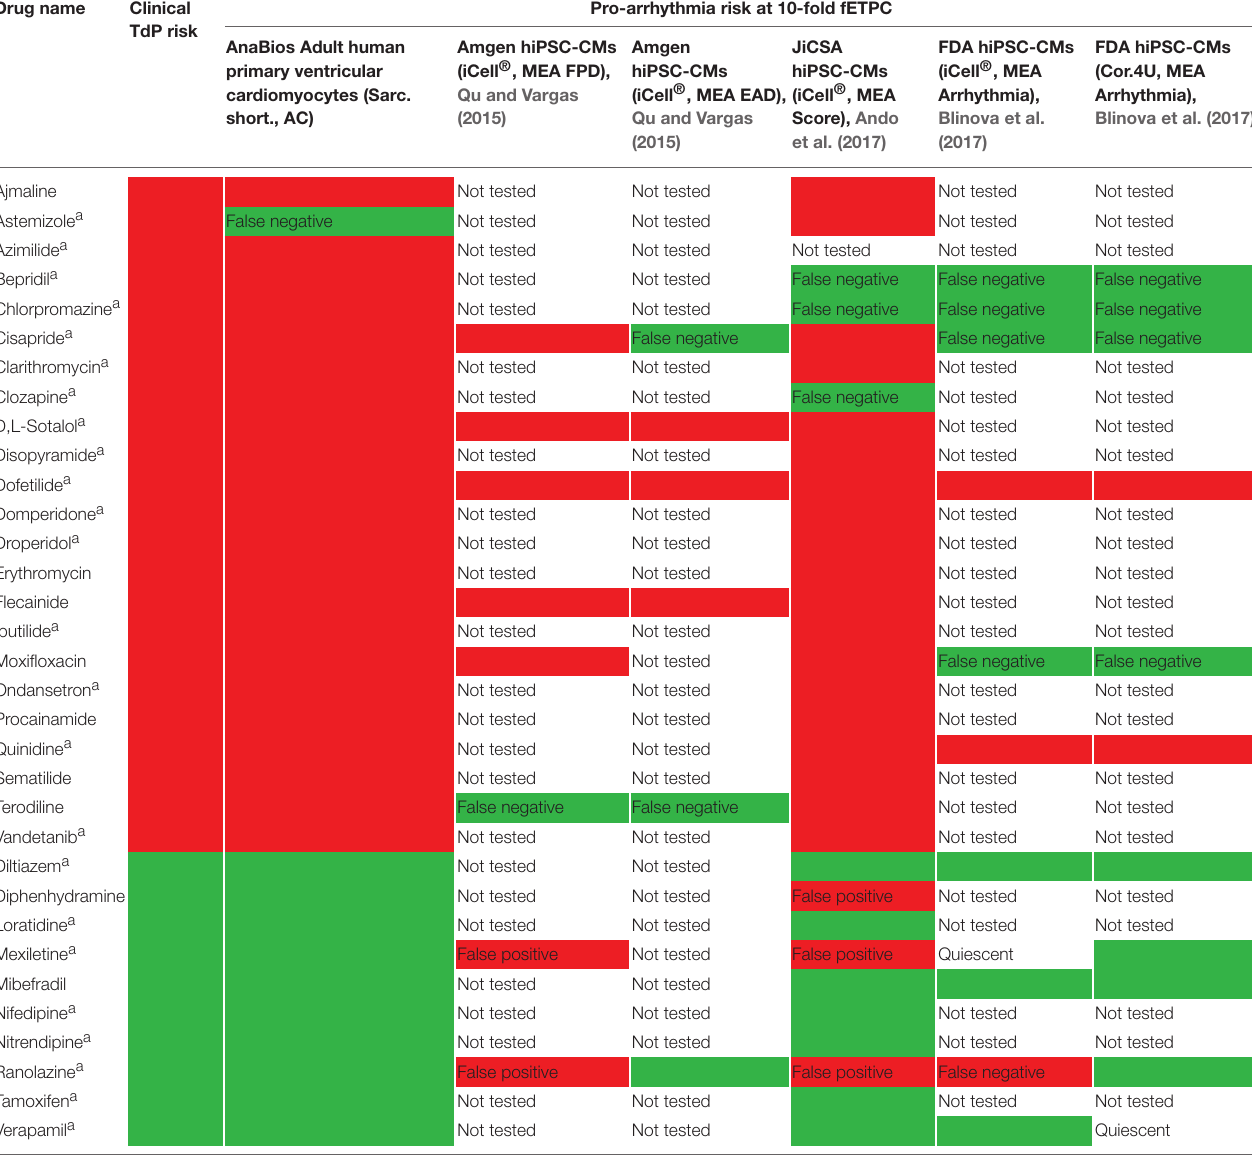
TABLE 4 | Pro-arrhythmia prediction of the adult human primary cardiomyocyte-based model. Drug